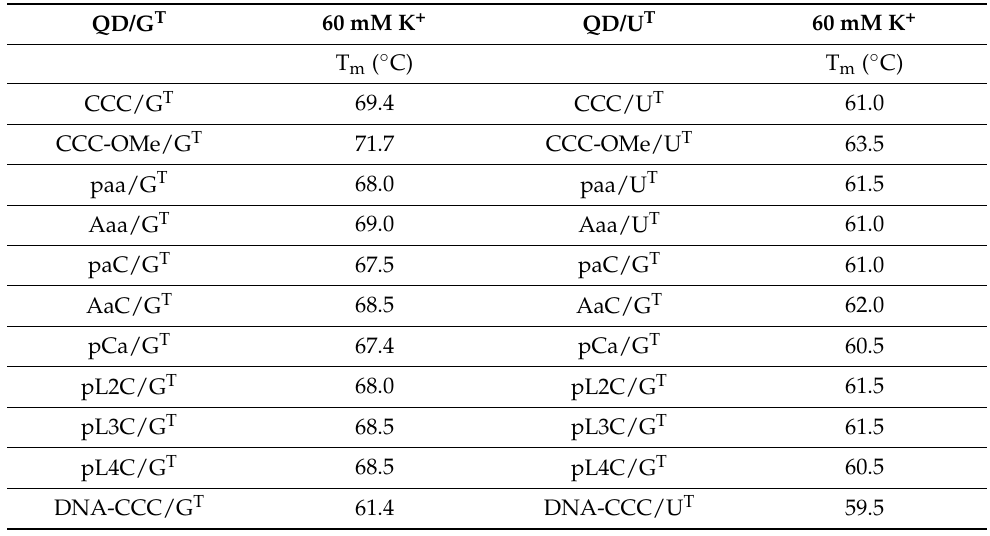
Table 2. Thermal stability for QDH and Dss structures in potassium phosphate